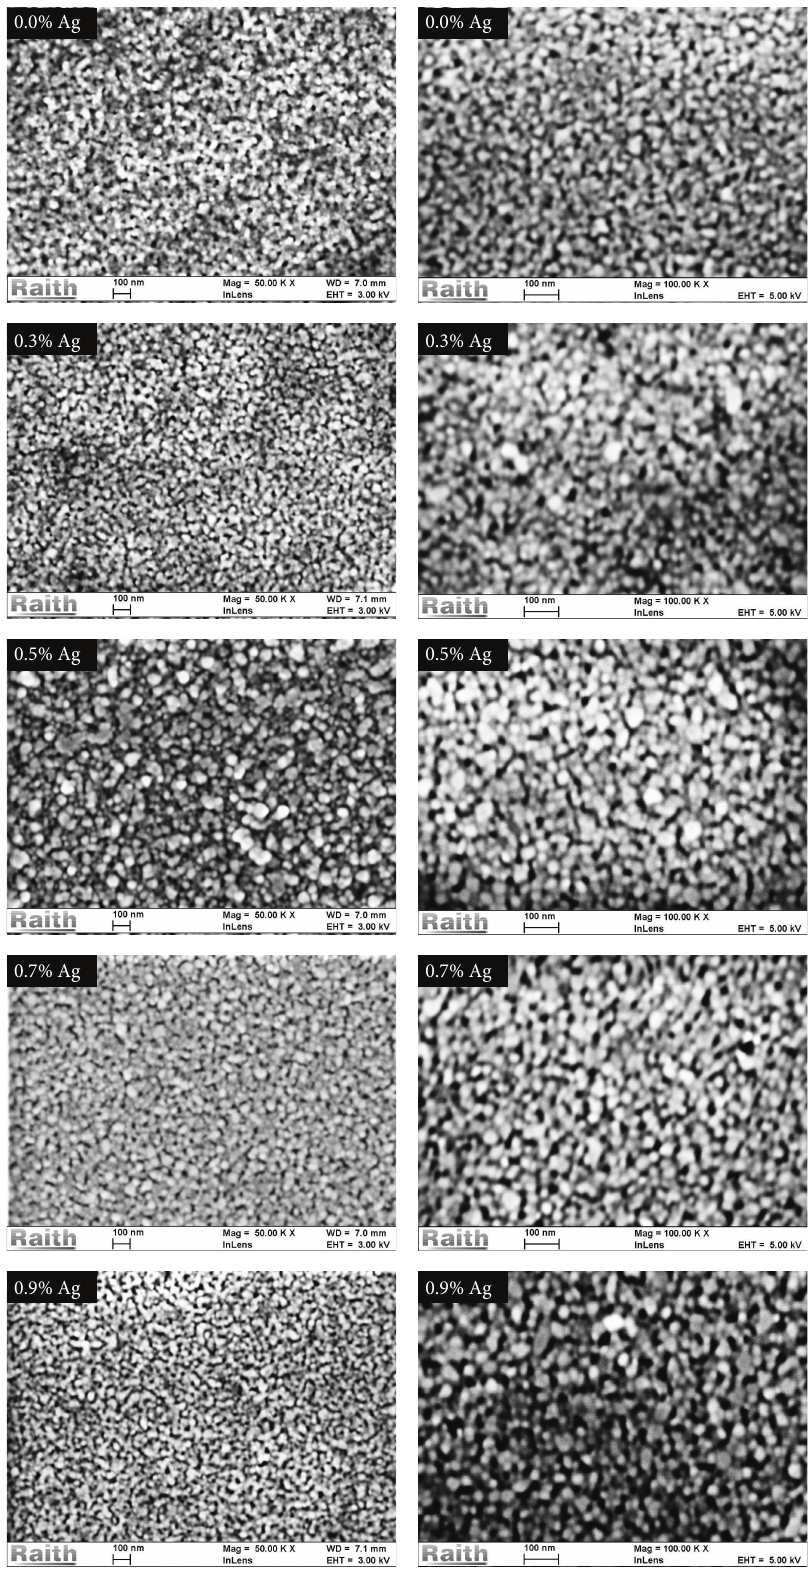
Figure 4: SEM micrographs of undoped and Ag doped ZnO thin films, × 50,000 magnification (on the left side) and × 100,000 magnification (on the right